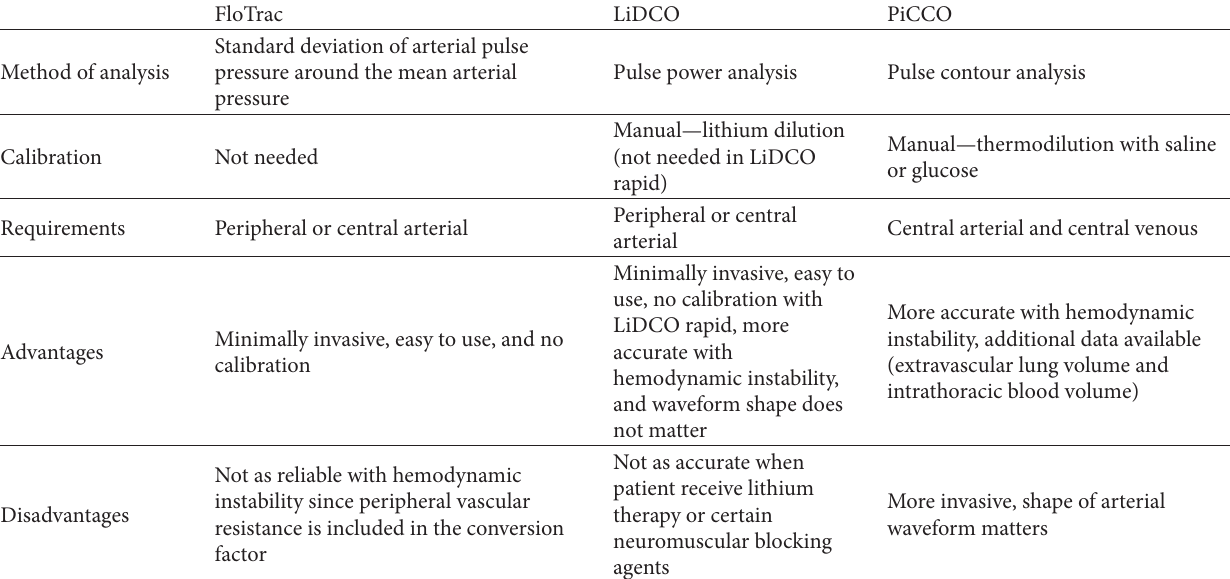
Table 1: Overview of the different arterial waveform analysis